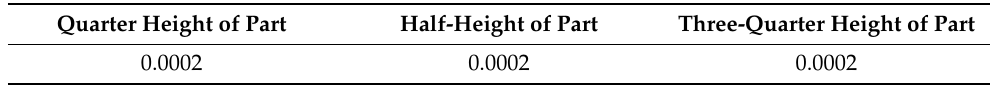
Table 5. Ellipticity in axial symmetry heat transfer simulation